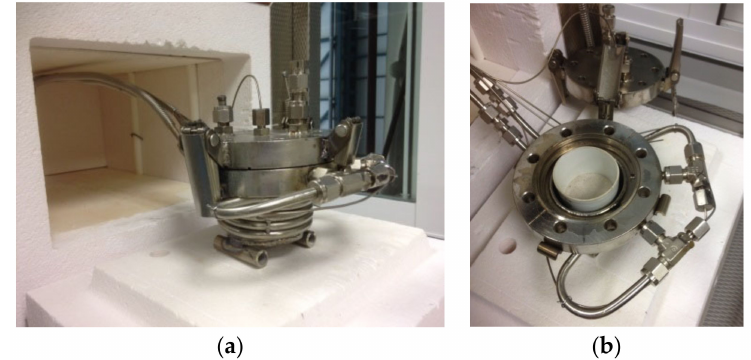
Figure 4. Setup outside and furnace ( a ) and setup inside ( b ) of the device “CIEMAT III”.